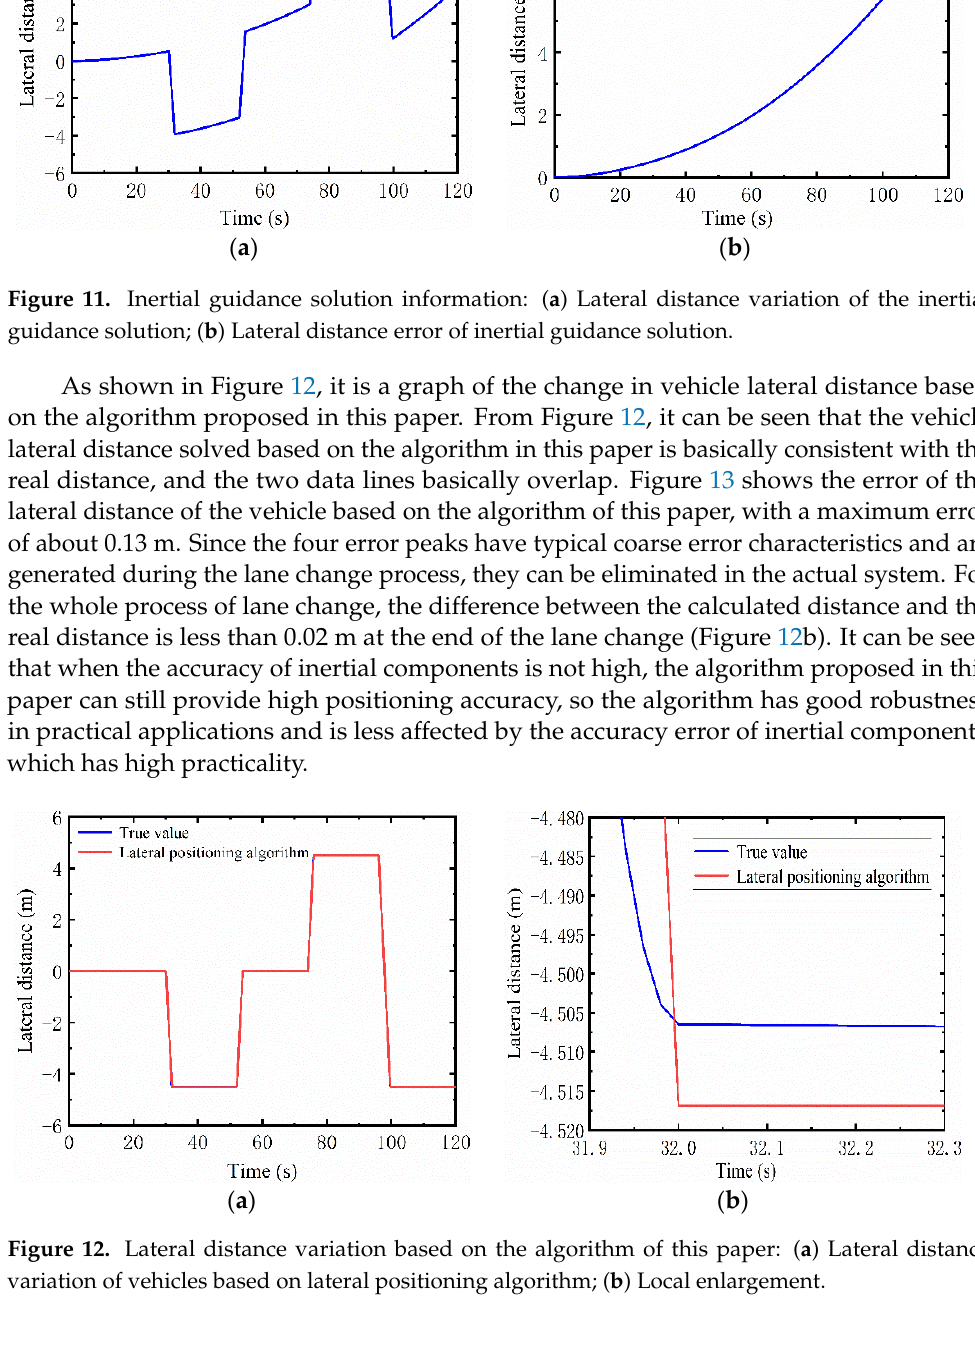
ation of vehicles based on lateral positioning algorithm; ( b ) Local enlargement.